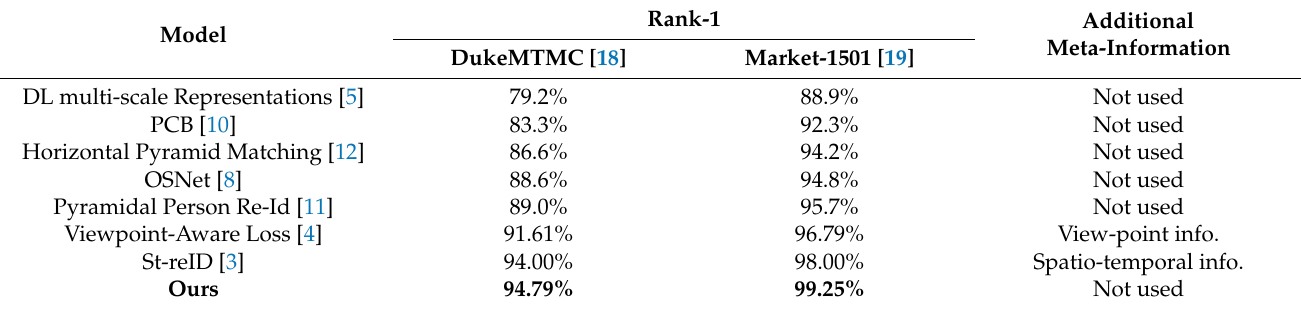
Table 5. Performance comparison with recent studies